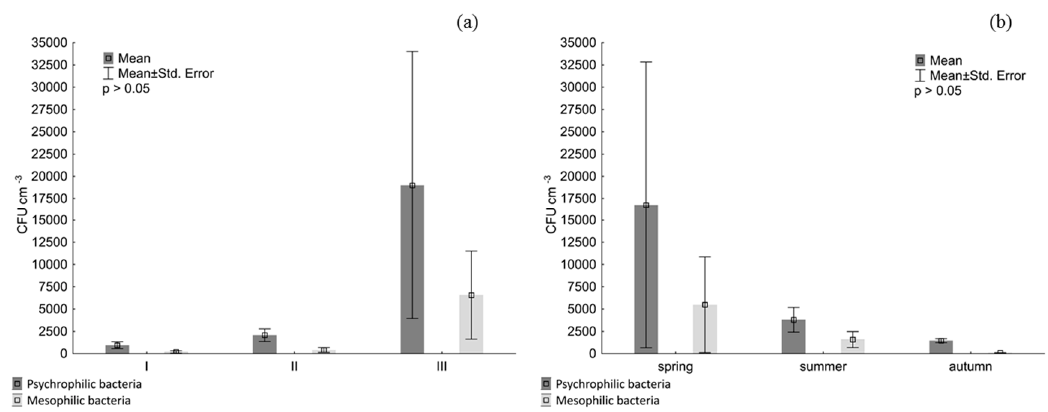
Figure 2. Average number of heterotrophic bacteria ( a ) at the research sites, ( b ) in the research seasons.